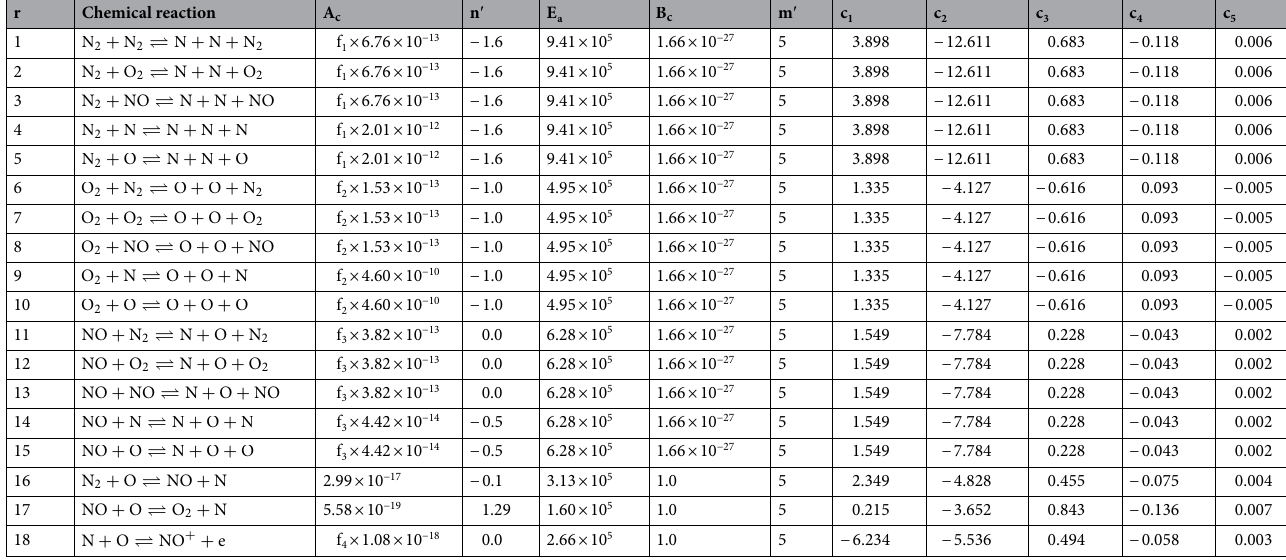
Table 2. Chemical reactions and reaction coefficients.